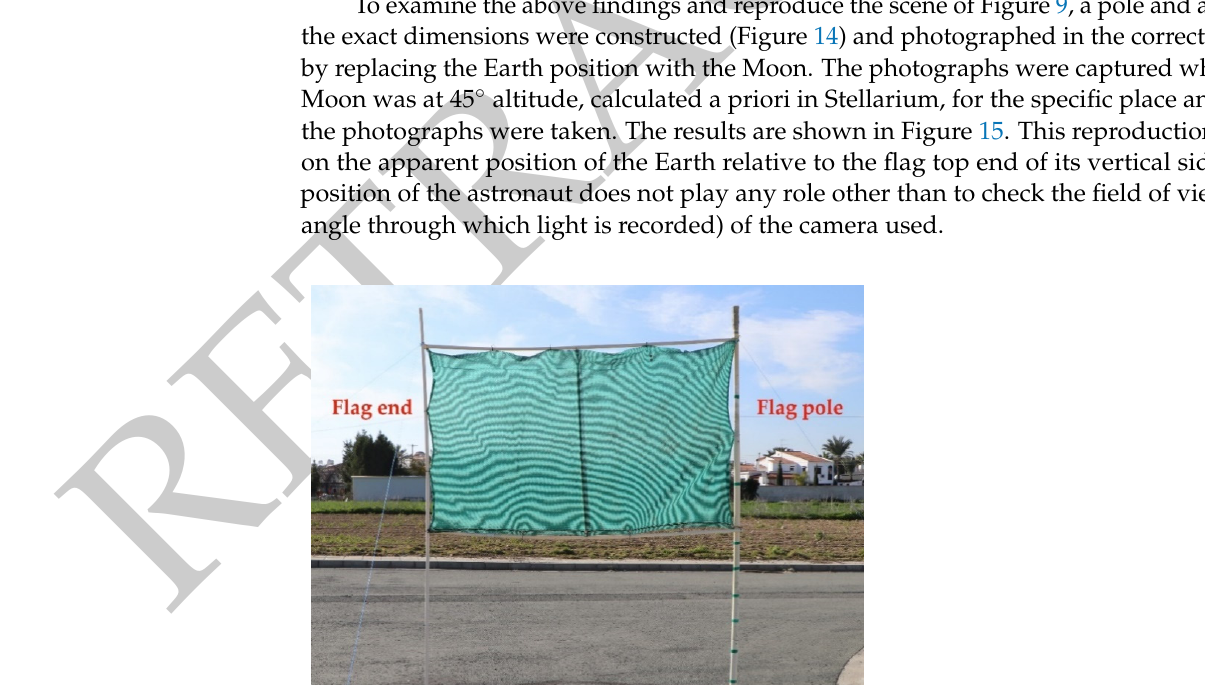
Figure 13. The apparent height of the Earth in photo AS17-134-20384 indicates that the astronaut- photographer, 1 m away from the flag end, can picture the Earth in the correct position on the photo when he holds his camera at 1.7 m above the ground.